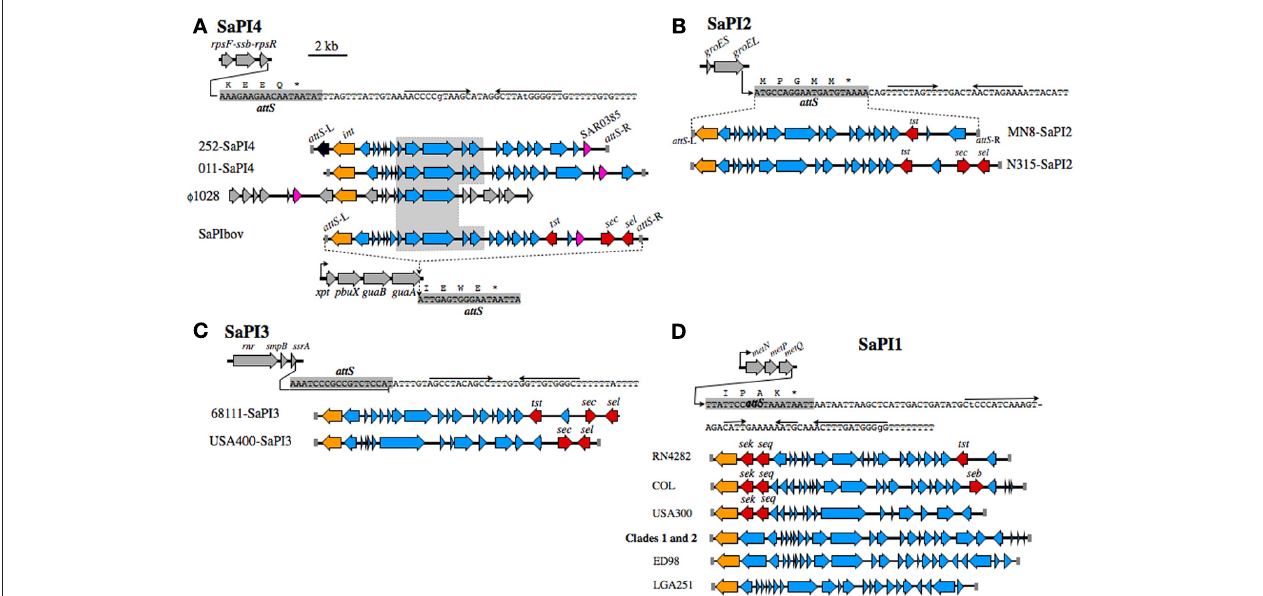
toxins are shaded red. The int of SaPIbov is shaded orange to emphasize function, although each SaPI family has a distinct int and attS . Structures of SaPI2 (B) , SaPI3 (C) , SaPI1 (D) , and their genomic insertion sites. Features are labeled as in A . SaPI2 of ST30 spa 33 strain MN8 (B) , is compared to SaPI2 of a non-related MRSA strain N315. SaPI3 (C) is not present in CC30. Structures shown are from strain USA400 [Baba et al. (2002)], which is a CA-MRSA, and strain 68111, which is a triple locus MLST variant of ST30 [Li et al. (2011)]. A clonal complex is comprised of isolates that differ from the ancestral sequence type (ST) at no more than two of seven MLST alleles. Therefore, S. aureus 68111 is distantly related to ST30, but is not within CC30. (D) shows SaPI1 structures from different strains, in comparison to SaPI1 in Clade 1 PT80/81 strains, and Clade 2 ST30 spa 19